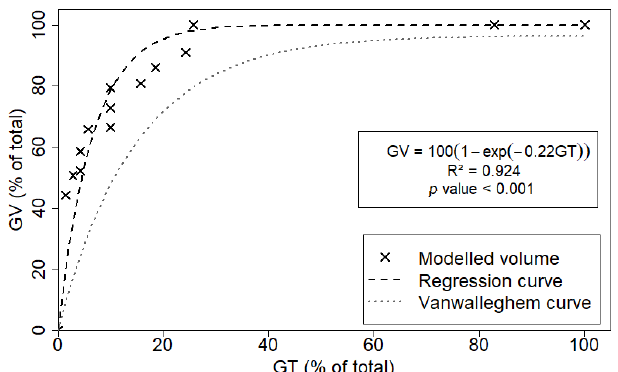
Figure 13. The behaviour of the gully growth rate as proposed in the literature (Vanwalleghem et al., 2005; Poesen et al., 2006) and modelled (data from gully 1). GV is the gully volume (in percent) and GT the gully age (in